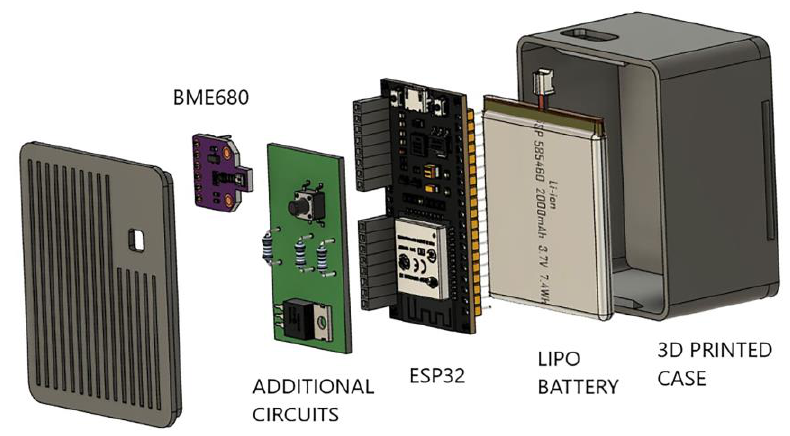
Figure 3. Schematic representation of the sensing node.